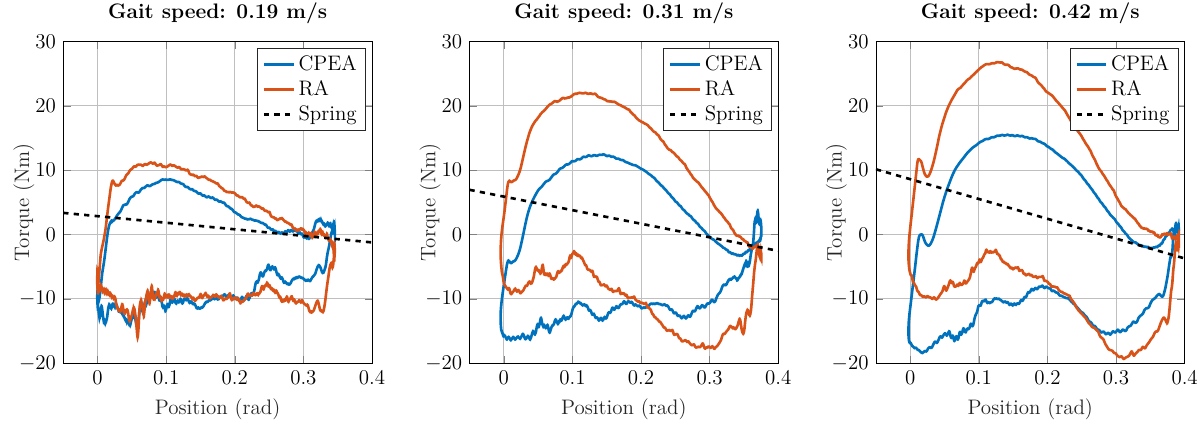
Figure 16. Angle and torque characteristics for the hip joint at three different gait velocities for an RA and